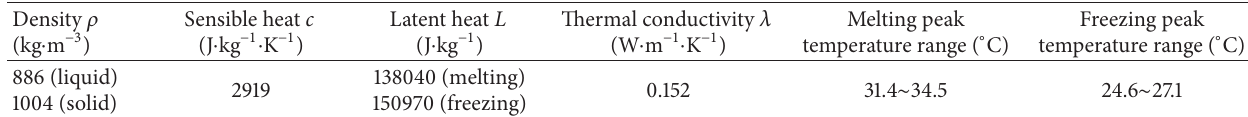
Table 1: Thermal-physical parameters of PCM (Capric